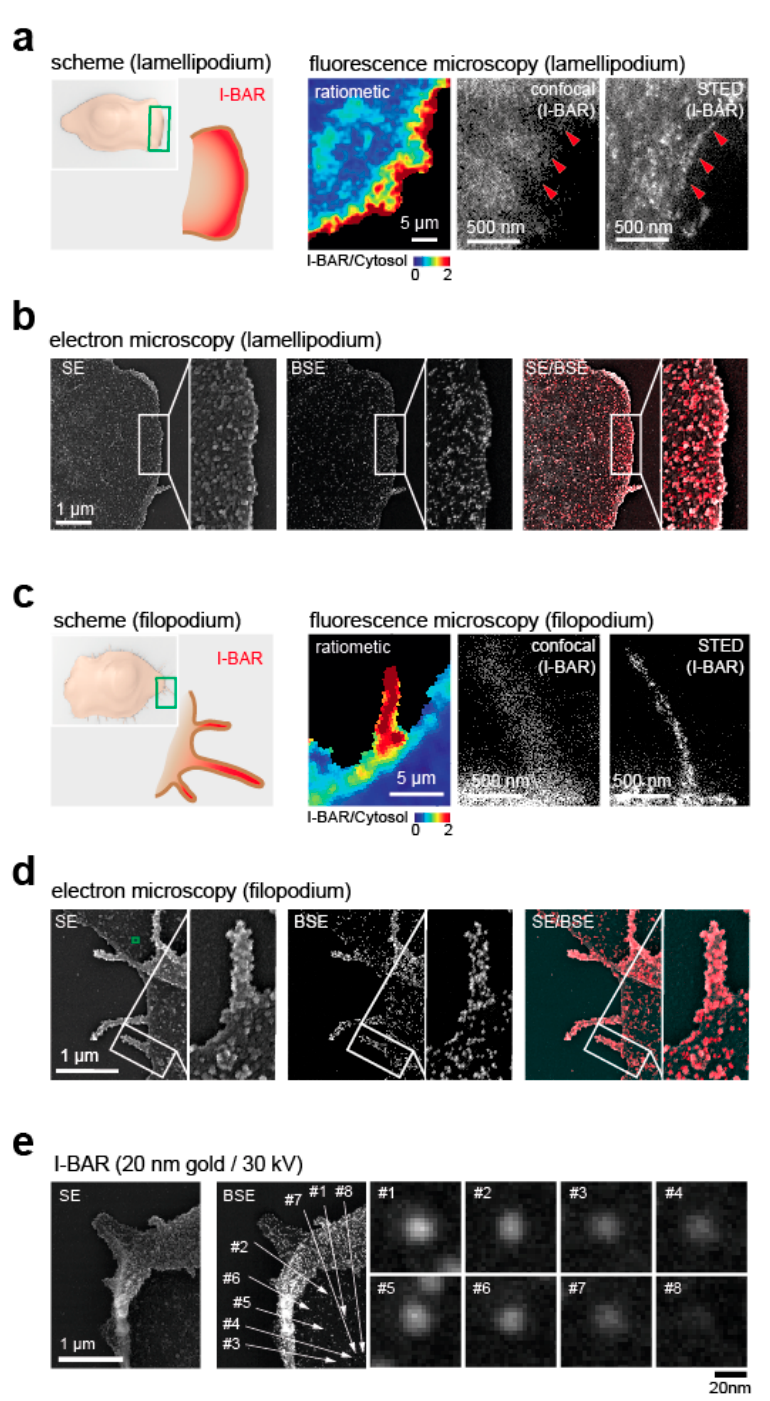
Figure 3. Validation of immunogold particle detection. ( a ) Fluorescence images of lamellipodia. To the left, scheme of I-BAR localisation (red) at the lamellipodial edge. Next to it, ratiometric image of I-BAR vs. cytosolic reference acquired in spinning disc confocal mode (inner left ), single channel confocal image (inner right ), and stimulated emission–depletion (STED) image ( right ). ( b ) Correlated SE / BSE of lamellipodium. Samples were transfected with an I-BAR domain tagged to GFP, labelled with a primary antibody against GFP and with a secondary antibody conjugated with 20 nm gold particles. The samples were captured in SE ( left ) and BSE mode ( middle ), and SE / BSE was merged for the region of a lamellipodium ( right ). Both images were acquired at 13,000 × magnification (5.57 nm per